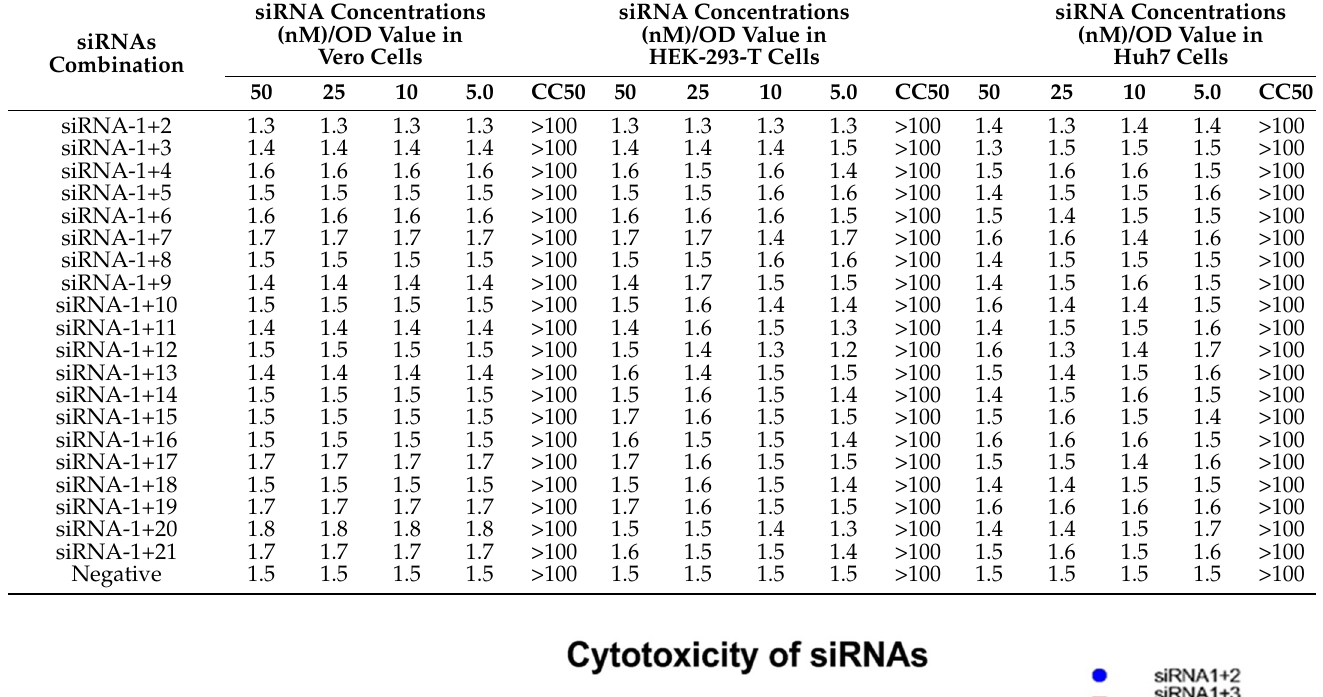
Table 2. Cytotoxicity (CC50) of siRNAs in selected cells.